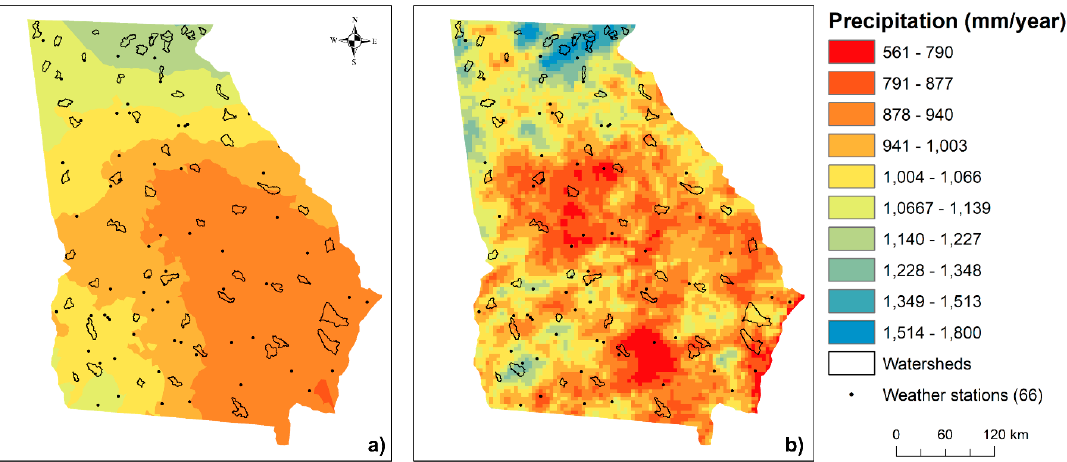
Figure 3. Precipitation grid with 30 m spatial resolution created interpolating rainfall and elevation (cokriging) data from weather stations in Georgia ( a ) [37], and precipitation grid with 4 km spatial resolution created by PRISM ( b ) (Copyright © 2018, PRISM Climate Group, Oregon State University, http://prism.oregonstate.edu. Map created on 03/16/2018) [36]. All watersheds used in this study are displayed in both maps. Precipitation is displayed as millimeters per year.